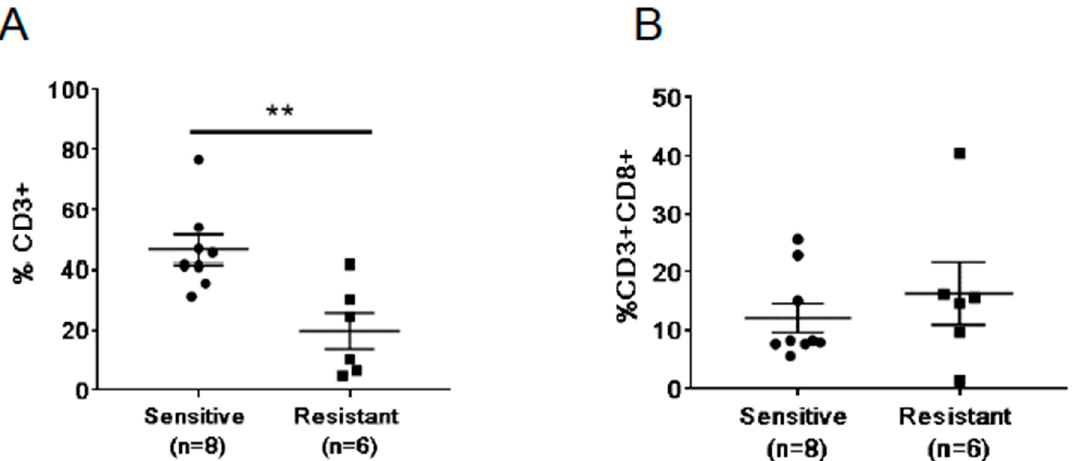
Figure 4. Di ff erences in frequencies of circulating T cells between abiraterone and / or enzalutamide treatment-resistant and -sensitive mCRPC patients. The percentage of CD3 + ( A ) and CD3 + CD8 + ( B ) T Figure 4. Differences in frequencies of circulating T cells between abiraterone and/or enzalutamide cells in the peripheral blood were analyzed using flow cytometry. ** p < treatment-resistant and -sensitive mCRPC patients. The percentage of CD3+ ( A ) and CD3+CD8+ ( B ) T cells in the peripheral blood were analyzed using flow cytometry. ** p < 0.01.